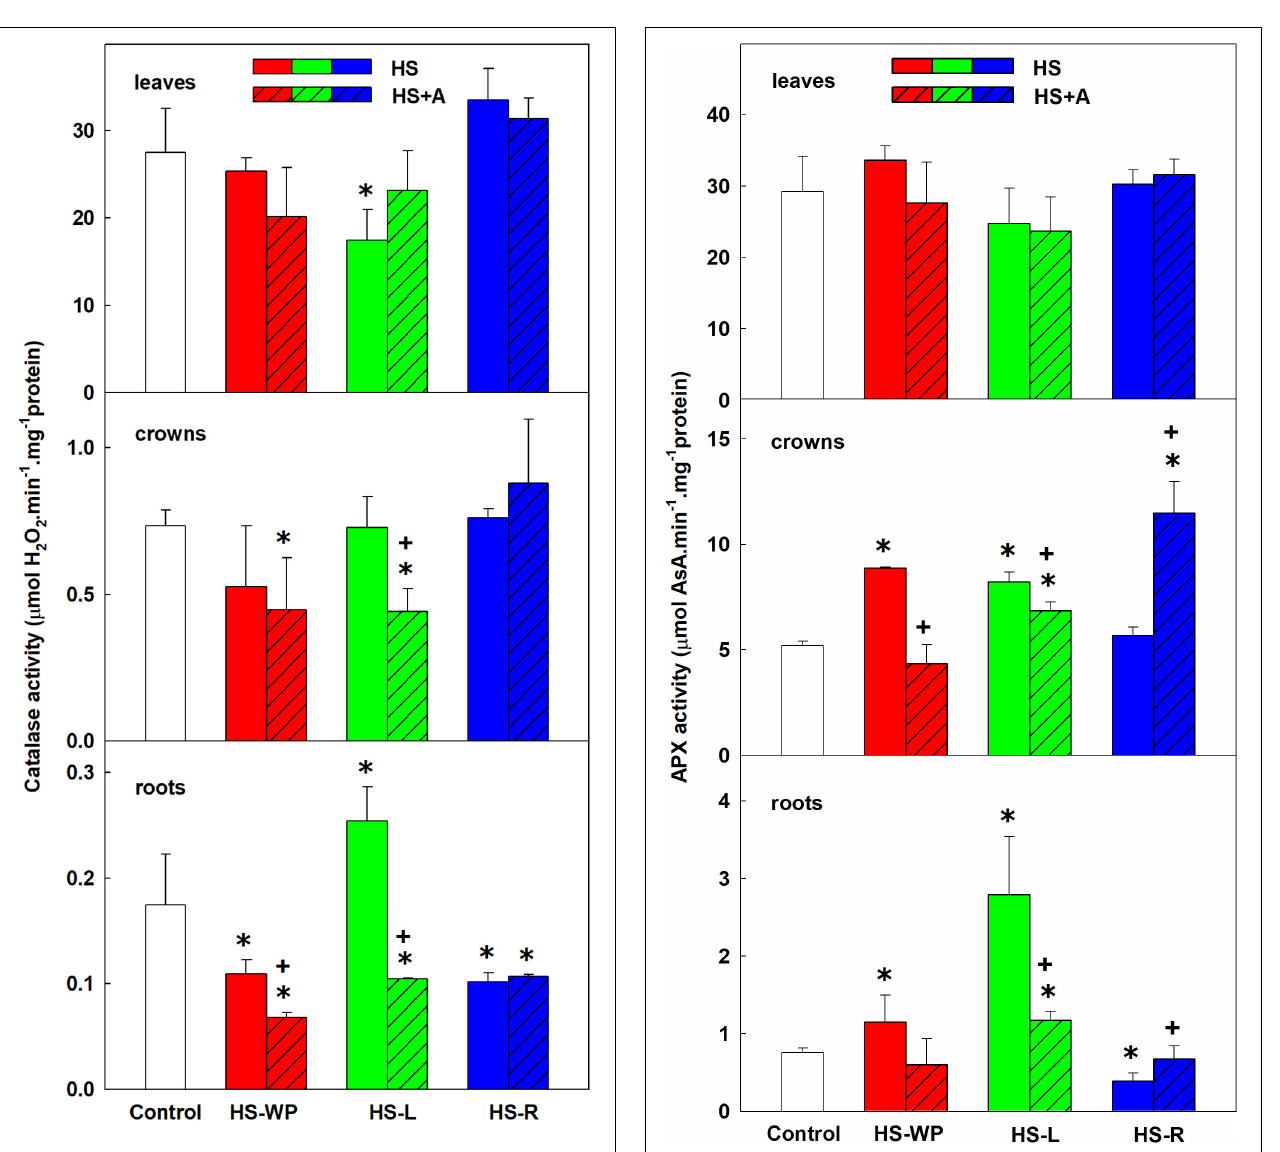
FIGURE 11 | The activity of catalase (CAT) in leaves, crowns and roots of rice seedlings exposed to heat stress directly (HS) or after acclimation (HS + A). Heat stress was applied to whole plants (HS-WP), to leaves (HS-L), or to roots (HS-R). Data are means ± SD. One-way ANOVA with Tukey’s post hoc test ( p < 0.05, n = 3) was used to compare controls to the HS treatments. Significant differences compared to control plants are indicated by asterisks ( ∗ ) while crosses (+) indicate significant differences between HS and HS + A treatments.